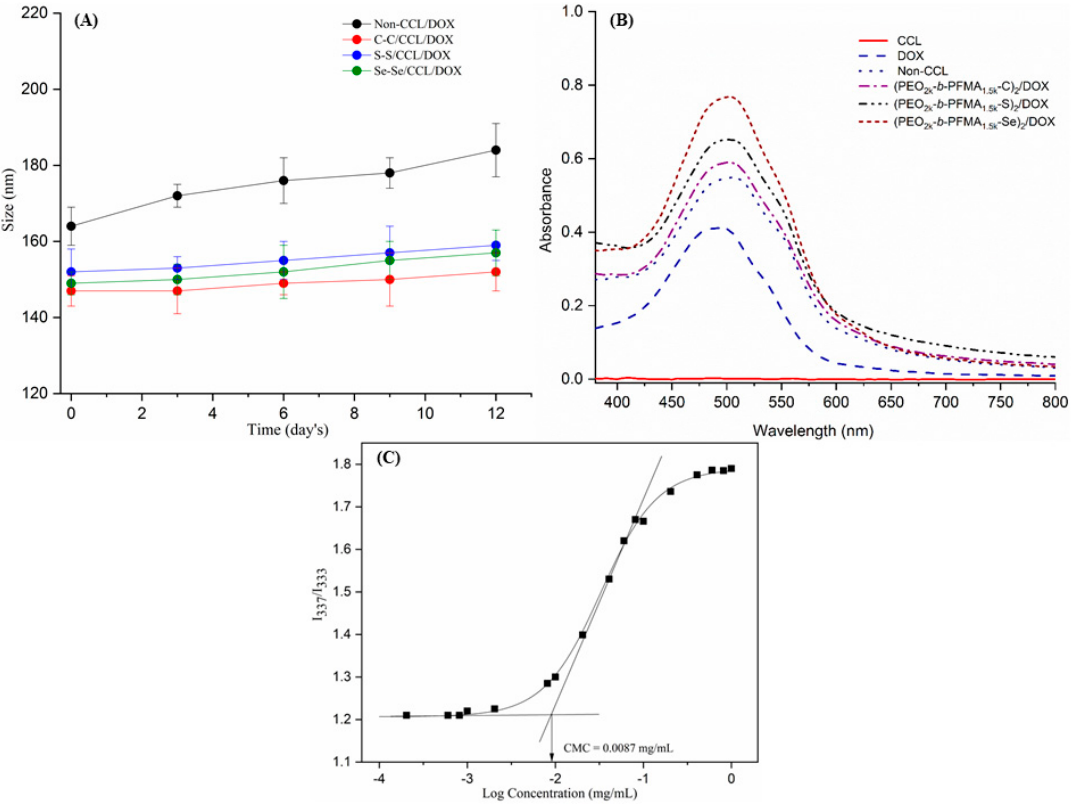
Figure 4. Stability of C–C/S–S/Se–Se CCL/DOX and non-CCL/DOX micelles ( A ), UV-Vis spectra of non-CCL/DOX, CCL, DOX, C–C/S–S/Se–Se CCL/DOX ( B ), and the plot of I 337 /I 333 vs. the logarithm of PEO 2k - b -PFMA 1.5k concentration ( C ).